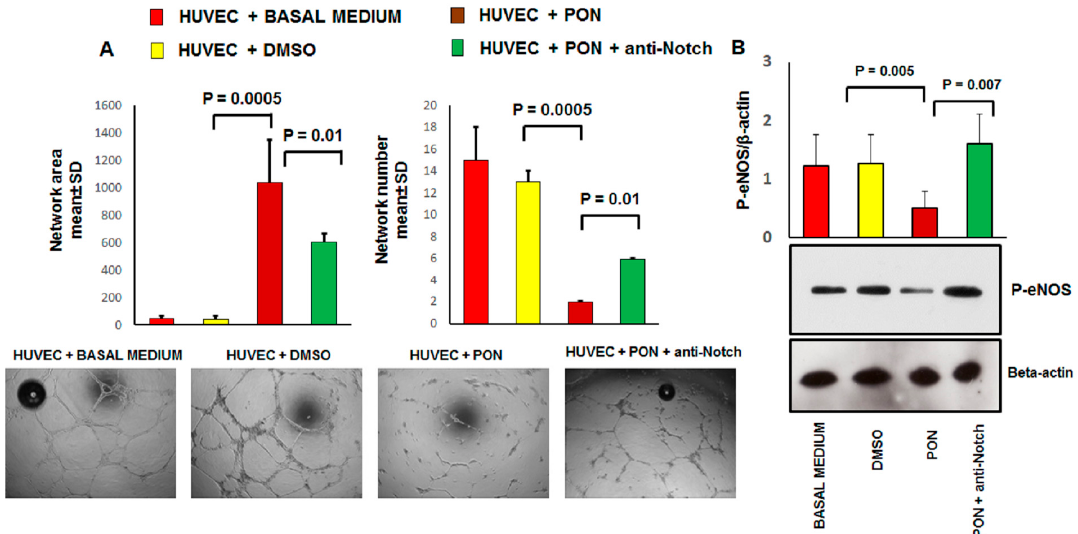
Figure 4. The e ff ect of ponatinib and Notch-1 signaling inhibition on tube formation and endothelial function. Panel ( A ), Human umbilical endothelial cells (HUVECs) were plated on matrigel-coated plates and treated with 1.7 nM of ponatinib or DMSO, in the presence or absence of 1 µ g / mL neutralizing factor anti-Notch-1 antibody. Tube formation was evaluated after 17 h by using light microscopy. Shown are representative fields (5 × magnification) of phase-contrast. The pictures are from one representative experiment. Quantitative data (panel ( A )) are presented as mean ± standard deviation of several parameters of tube formation. n = 3 independent experiments, with at least 7 replicates per each group. Panel ( B ), western analysis of phosphorylated eNOS expression in HUVECs treated with 1.7 nM ponatinib or DMSO, in the presence or absence of 1 µ g / mL of neutralizing factor anti-Notch-1 antibody, with β -actin serving as a loading control. The bar graph represents for each value the mean ± S.D. from 3 separate experiments. Abbreviations: Pon, ponatinib; DMSO, dimethyl